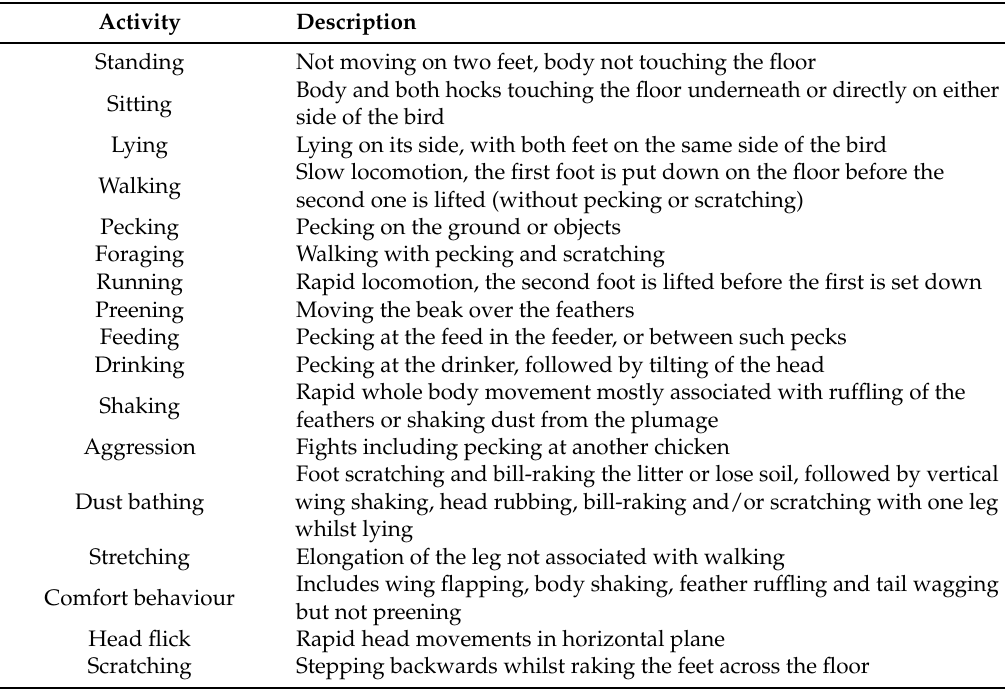
Table 1. Ethogram of behaviours under observation (Adapted from Buijs, [24]).